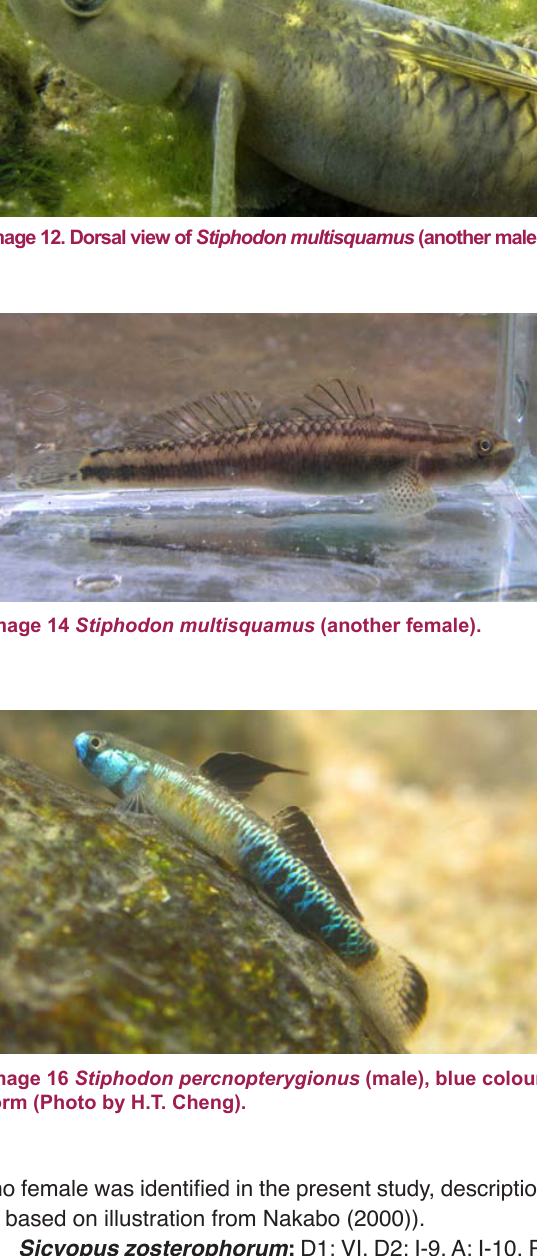
Female: body with two prominent transverse stripes